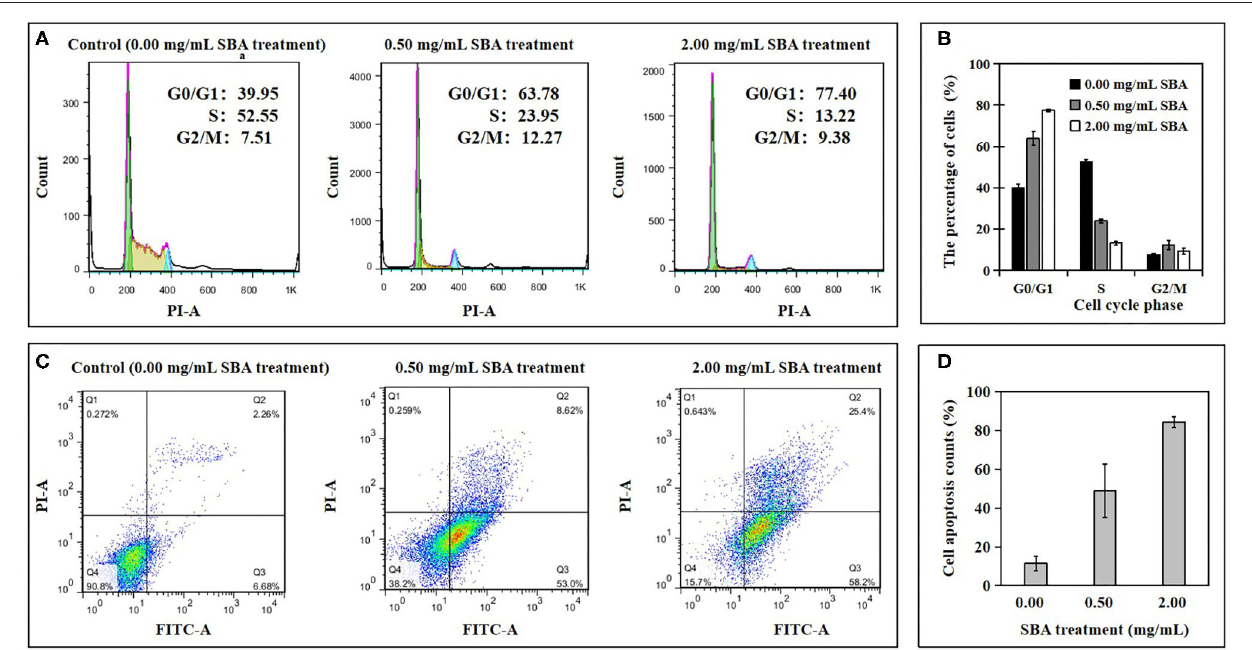
FIGURE 1 | The percentage of the cells at different cell cycle phases and apoptosis rates in DST. After being treated with 0.0, 0.5, or 2.0 mg/mL SBA for 24h, the cell cycle and cell apoptosis in DST were evaluated using FCM. Cell cycle (A) and its analysis (B) , cell apoptosis (C) , and its analysis (D) .